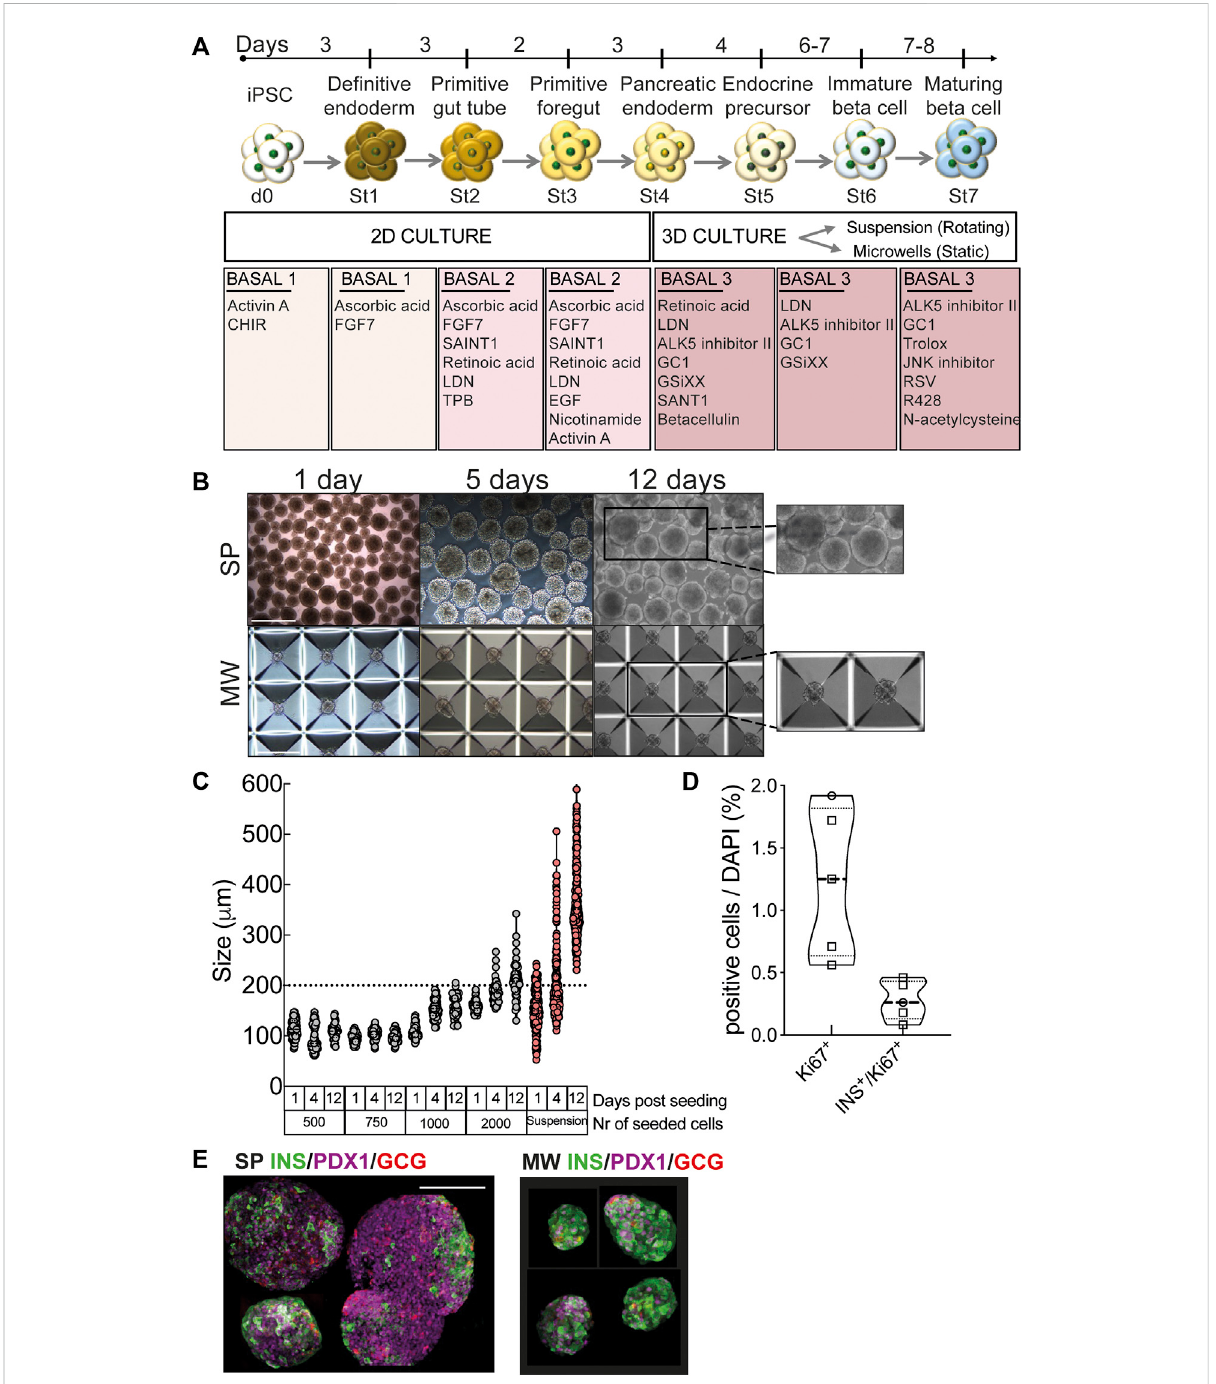
FIGURE 1 Human iPSC differentiation into beta cells. (A) , Human iPSCs were differentiated into beta cells following a 7-stage stepwise protocol. Until stage4(St4)cellswereculturedin2Dandthentransferredto3Dculture,eitherinsuspension(SP)ormicrowells(MW).Mediaspeci fi cationisshownin boxes. (B) ,Morphologyandsizeofaggregatesdifferentiatingintobetacellsinrotatingsuspension(upperpanels)orstaticmicrowells(bottompanels) at 1, 5 and 12 days post-detachment from 2D culture. Scale bar is 400 µm. (C) , Diameter of the aggregates generated with 500, 750, 1000 or 2000 cells per microwell. Diameters were measured at day 1, 4 and 12 post-detachment from 2D culture. (D) , Quanti fi cation of immunochemical analysis of total or insulin-positive cells (co-)expressing the proliferation marker Ki67 (n = 5). (E) , Microwell and suspension aggregates stained for insulin (green), glucagon (red) and PDX1 (purple). Scale bar is 100 µm. Symbols represent different cell models (Hel115.6, circles; 1023A, squares). N, number of independent experiments, de fi ned as one iPSC-beta cell differentiation, shown as individual data